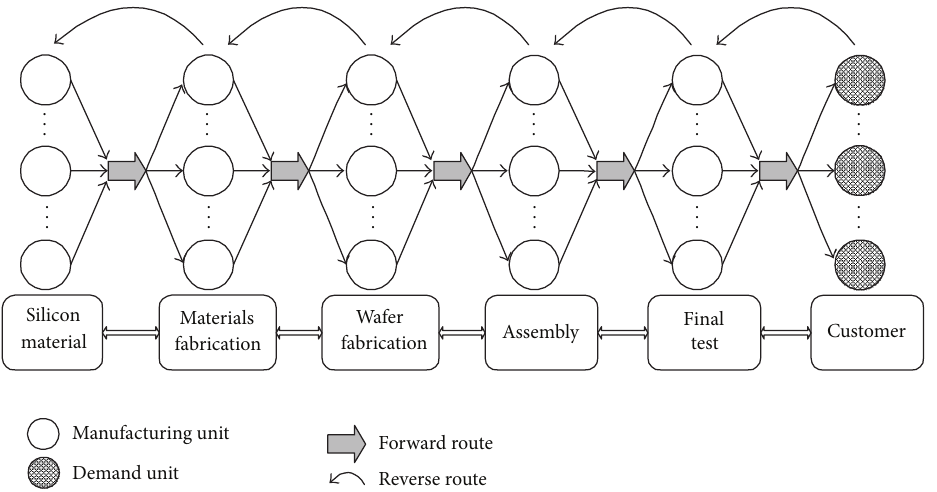
Figure 9: Typical supply chain network for